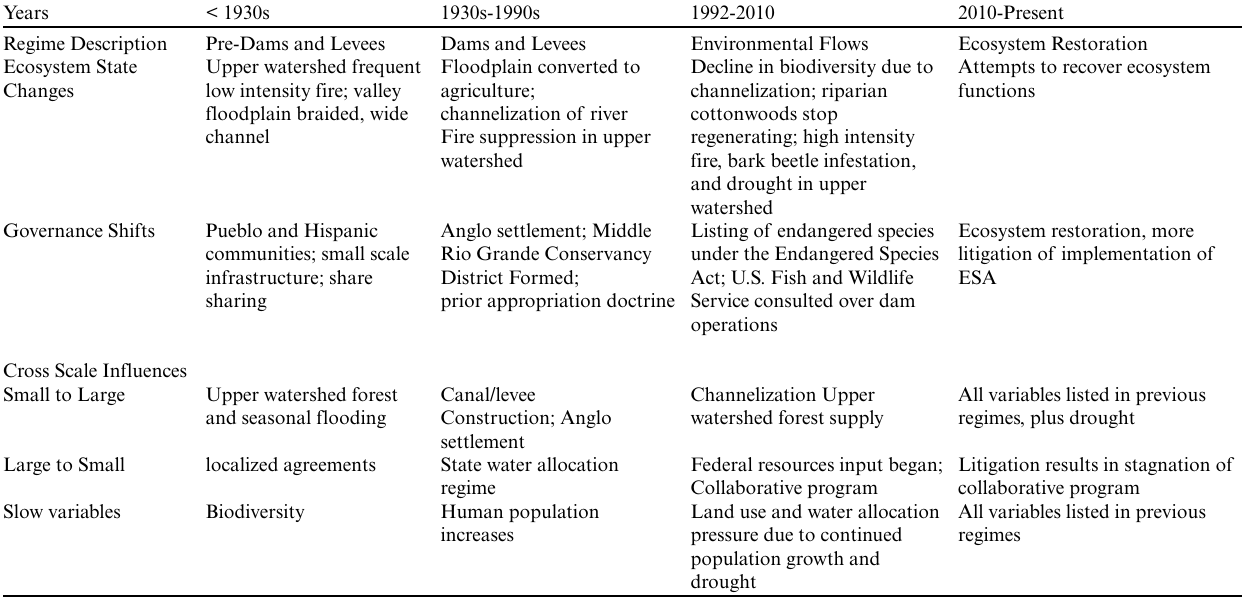
Table 7 . Resilience assessment of historical changes in the Middle Rio Grande. New Mexico’s Middle Rio Grande watershed includes the urban environments of Albuquerque, Santa Fe, as well as surrounding small towns, and rural agricultural communities. Dams and levees provided the necessary infrastructure for Anglo settlement, but resulted in loss of biodiversity. Pressures of urbanization, water supply constraints, and a history of a highly variable and unpredictable water availability are requiring increased adaptive capacity in the social system. The upper watershed forest system is undergoing regime change due to historic fire suppression followed by drought conditions. Long-term climate change projections indicate that the watershed will experience ongoing drought in the coming decades, with water shortfalls and extended dry intervals expected to become increasingly